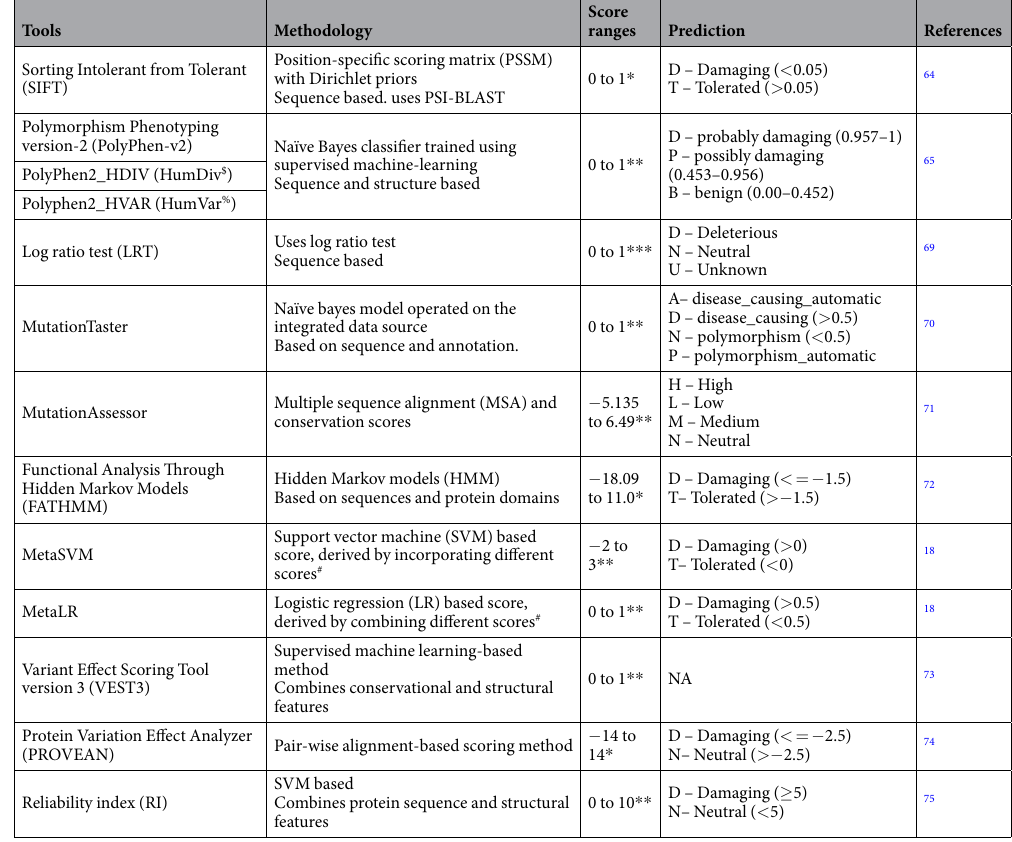
Table 2. Summary of used tools for deleteriousness prediction for missense variants. * Lower scores indicate deleterious nature. ** Higher scores indicate deleterious nature. *** Score cannot decide deleterious nature. $ HumDiv - collection of mendelian disease variants (5564 deleterious + 7539 neutral in 978 human protein) against divergence from close mammalian homologs of human proteins ( > = 95% sequence identity). % HumVar - compilation of all human variants (22196 deleterious + 21119 neutral) associated with some disease (non-cancer mutations) or loss of activity/function vs. common (MAF > 1%) human polymorphism with no reported association with a disease. # 10 scores from SIFT, PolyPhen-2 HDIV, PolyPhen-2 HVAR, GERP ++ , MutationTaster, Mutation Assessor, FATHMM, LRT, SiPhy and PhyloP and the maximum frequency observed in the 1000 G